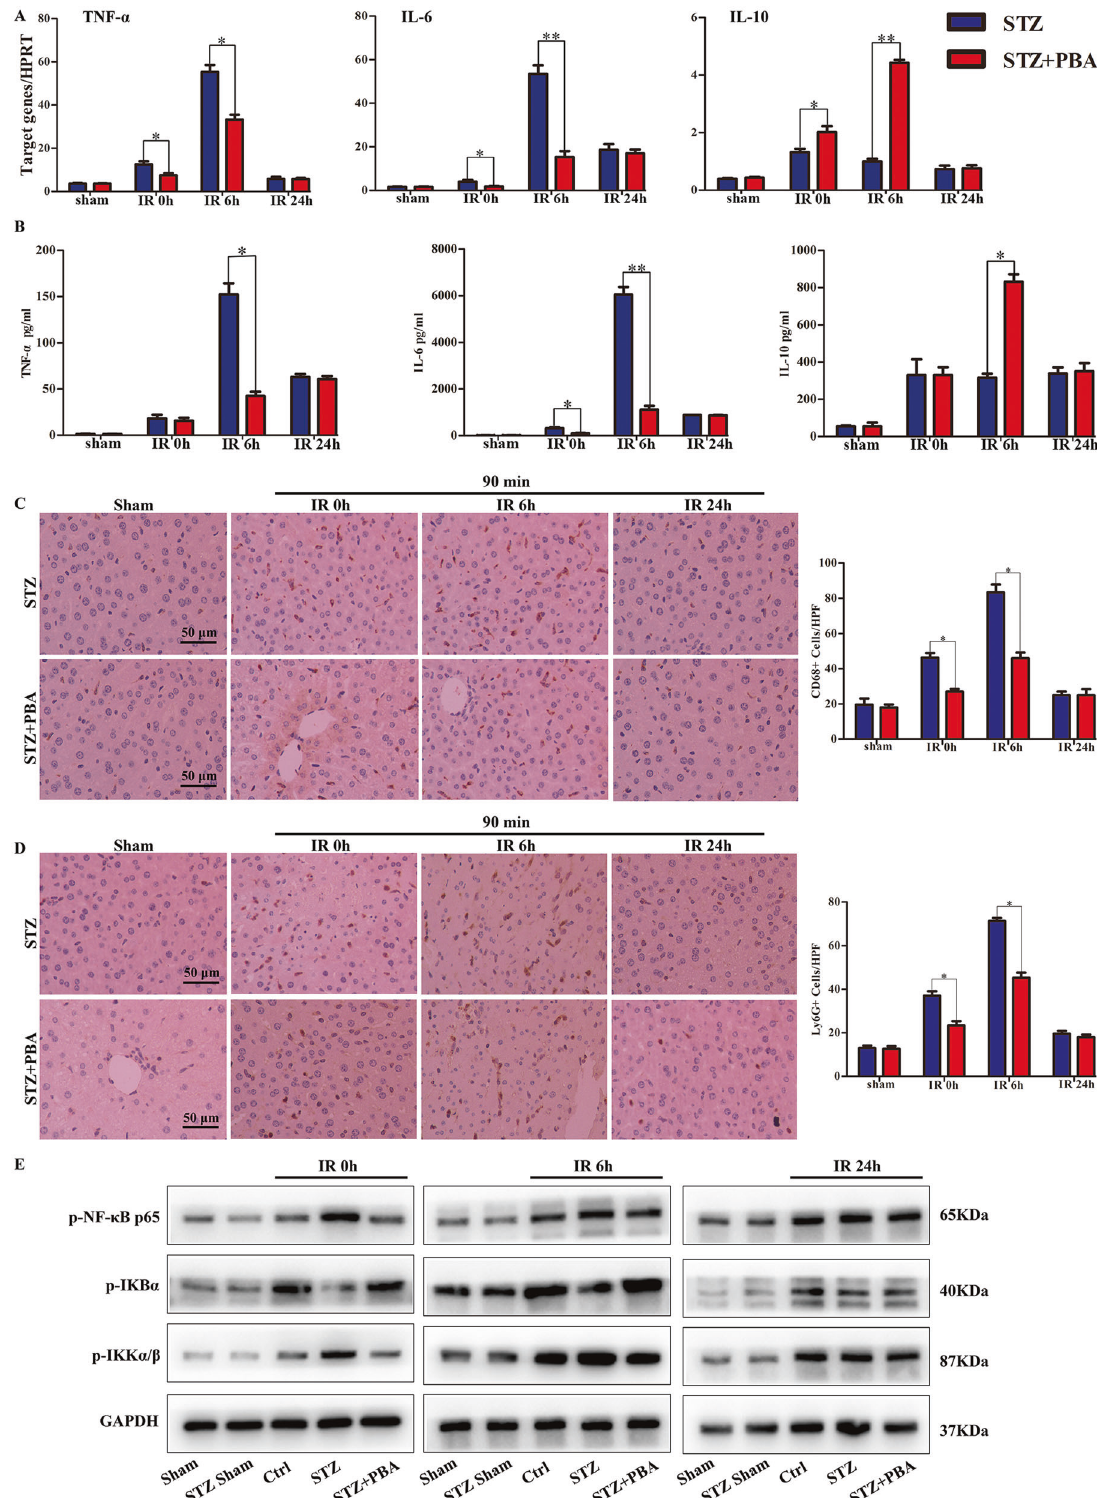
Fig. 3 ATF6-CHOP pathway was essential for the hyperglycemia-promoted pro-in fl ammatory response in liver IRI. A TNF- α , IL-6, and IL-10 mRNA levels were examined by qRT-PCR and B the serum cytokine levels were measured by ELISA. C , D The in fi ltration of neutrophil and macrophage were analyzed by IHC (×200). CD68 + and Ly6G + cells were quantitated by counting positive cells and the quanti fi ed results are shown as the right panels. E Protein expression detection of p-IKB α , p-NF- κ B p65, p-IKK α / β , and GAPDH. Data are representative of three independent assays with consistent results. * P < 0.05, ** P < 0.01.